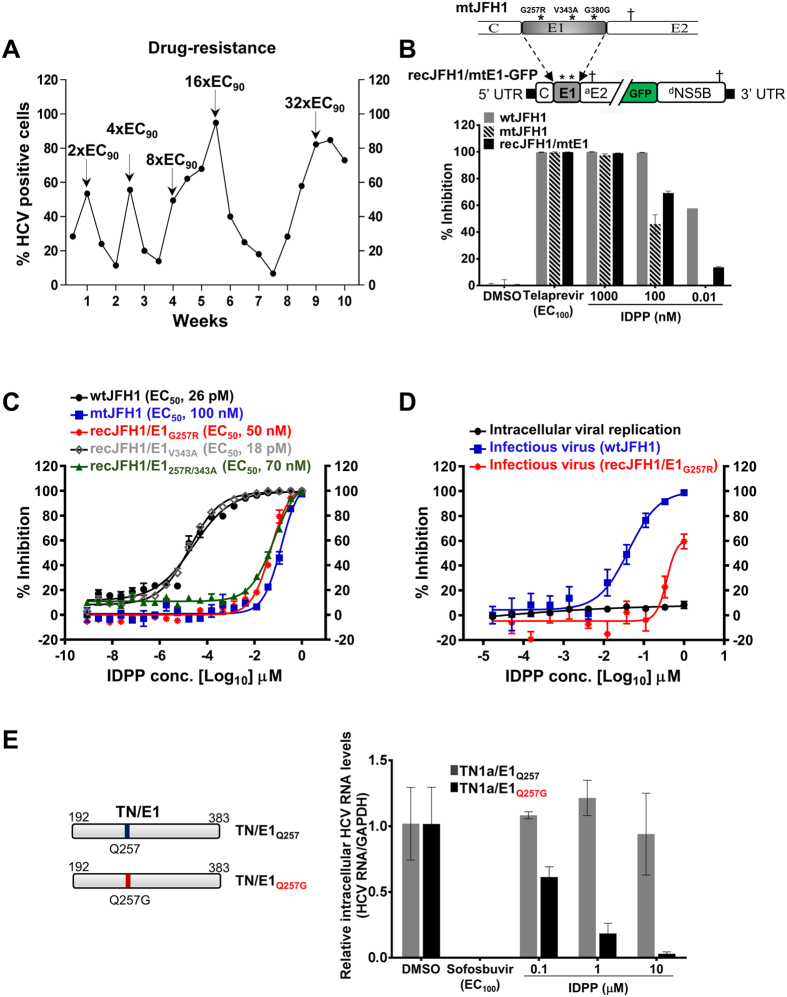
Viral IDPP resistance study and generation of IDPP-susceptible HCV genotype 1 variant.(A) IDPP-resistant HCV was created by culturing of JFH1-GFP virus-infected Huh-7.5 cells with increasing compound concentrations (2-fold) as indicated. (B) Three mutations in glycoprotein E1 were identified and are indicted by asterisks ‘*’ (upper). Resistance to IDPP was evaluated with recombinant viruses (lower). (C) DRC analysis with IDPP-recombinant viruses including the given amino acid substitutions. (D) Supernatant transfer assay with parental (wtJFH1) and IDPP-recombinant virus (recJFH1/E1G257R). (E) Generation of IDPP-susceptible genotype 1 virus (TN) by amino acid substitution (Q257G) in HCV E1 glycoprotein. At 72 h p.i., intracellular HCV RNA levels were determined by qRT-PCR. Relative HCV RNA levels normalized to GAPDH are shown.